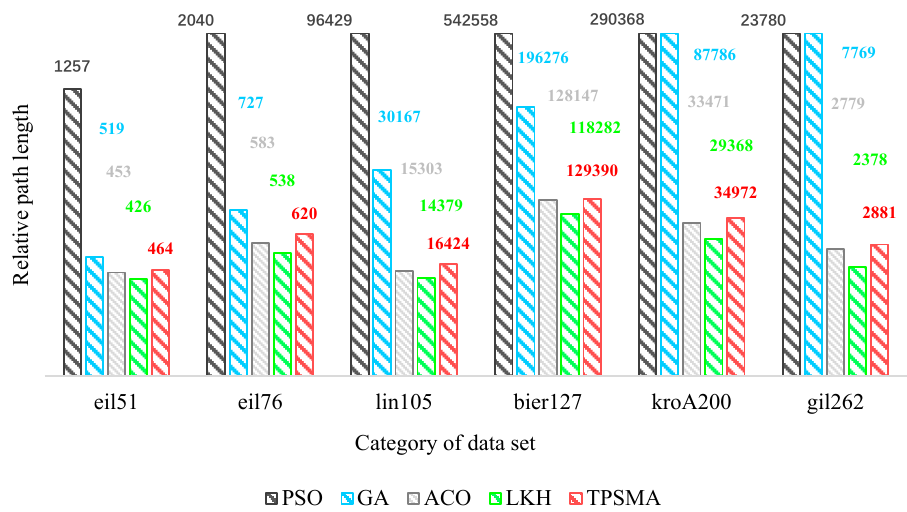
Figure 14. Comparison of optimization results under TSPLIB data sets.